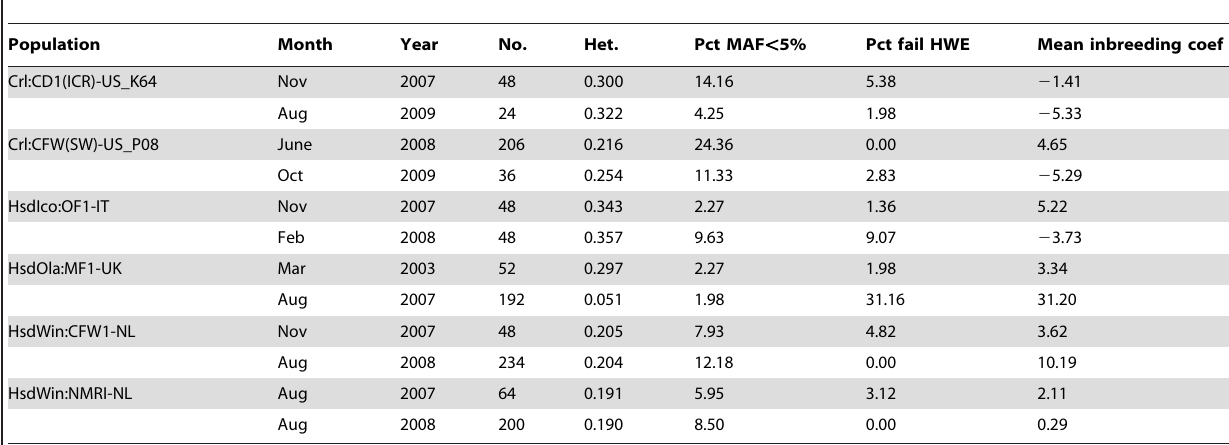
Table 2. Temporal